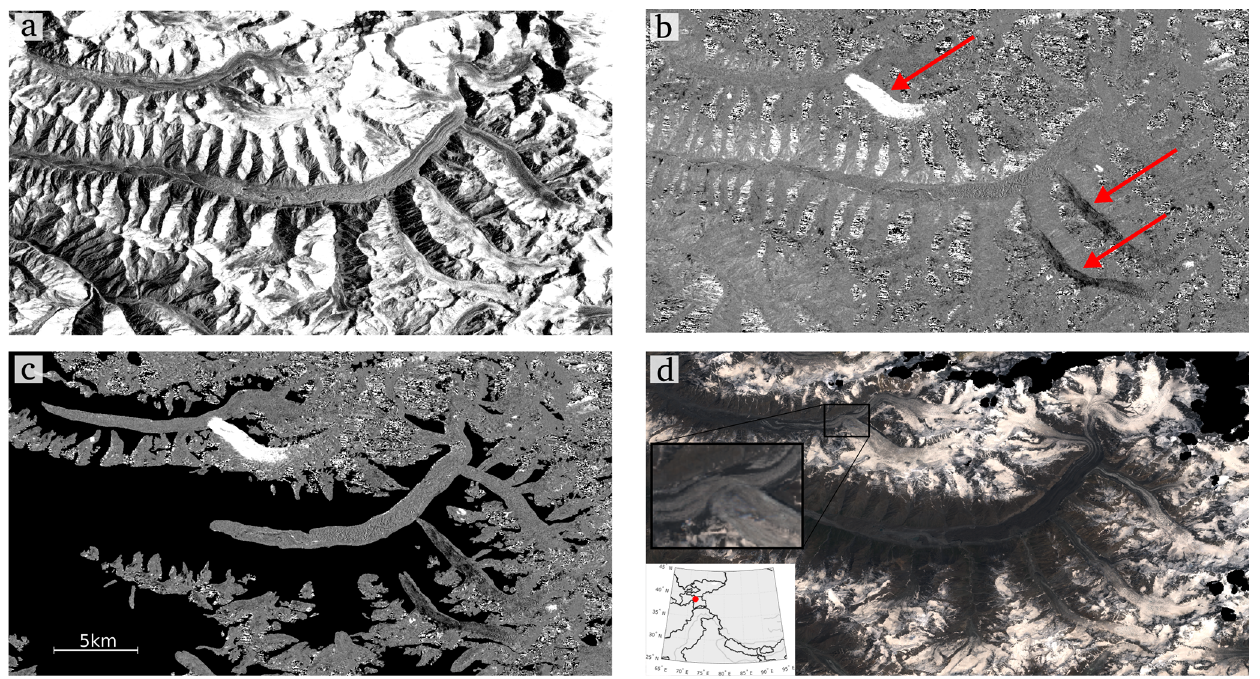
Figure 1. Example for detecting glacier surges from differencing backscatter stack maxima of different winter seasons for a glacierized area surrounding the Obihingo (also called Obikhingou) river basin in the central Pamirs, Tajikistan. (a) Aggregated Copernicus Sentinel-1 maximum backscatter winter 2018. (b) Normalized Difference Index (NDI) image from Sentinel-1 maximum backscatter winter 2018– winter 2019. Arrows indicate areas with increased and decreased radar backscatter over glaciers: Gando Glacier, Vanchdara Glacier, and Shocalscogo Glacier, from top to bottom. (c) NDI image 2018–2019 masked with GLIMS glacier outlines. (d) Copernicus Sentinel-2 optical image summer 2019, with cloud mask in black and zoomed-in view of the protruding in the main trunk of Gando Glacier; inset shows the location of the